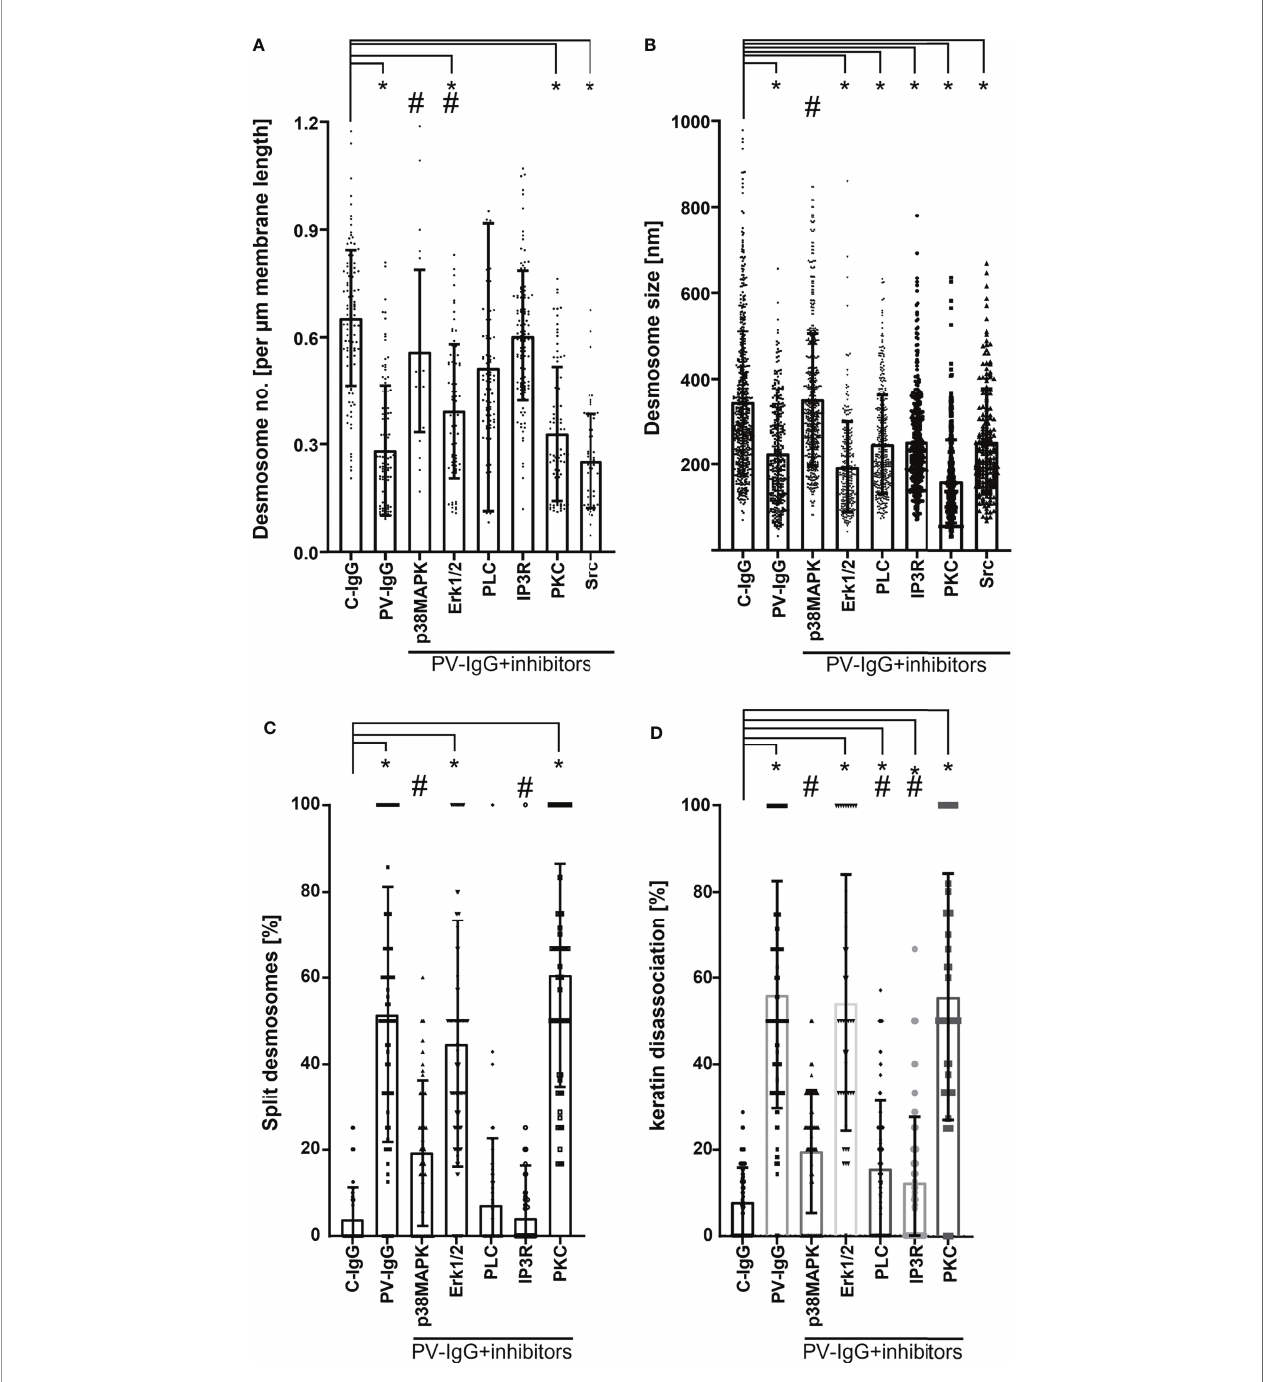
FIGURE 3 | Ultrastructural quanti fi cation of desmosomes. (A) Desmosome density expressed in number of desmosomes per µm membrane length. Only desmosomes along clearly delineated cell borders of basal cells were considered. (B) Desmosome size measured along the linear length of the plaques and expressed in nm. (C) Percentage of split desmosomes both in acantholytic and non acantholytic areas. (D) Percentage of keratin dissociation from desmosomal plaques. Each data point represents individual desmosomes for (B) , and the average per electron micrograph for (A, C and D) (n= 3-5 for each pathway. *p < 0.05 vs. control, #p < 0.05 vs. PV- IgG). Inhibitors used: SB202190 – p38MAPK inhibitor, Pp2 – Src inhibitor, Bim-X – PKC inhibitor, UO126 MEK (upstream of Erk1/2) inhibitor, U-73122 – PLC inhibitor, Xest (xestospongin) – IP3R